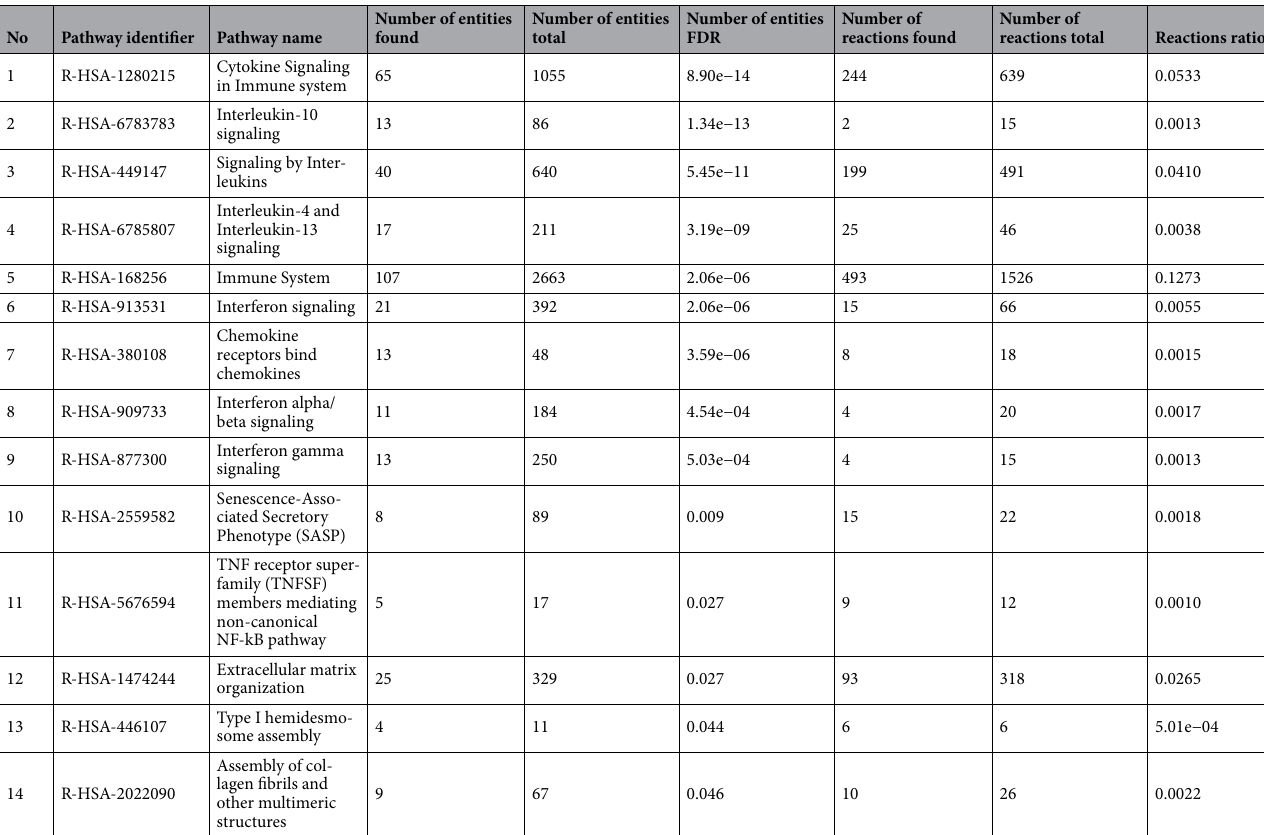
Table 3. DEGs involved in the biological processes, categorized by Reactome server (transcriptomes induced after exposure of hBMECs to Lbp).